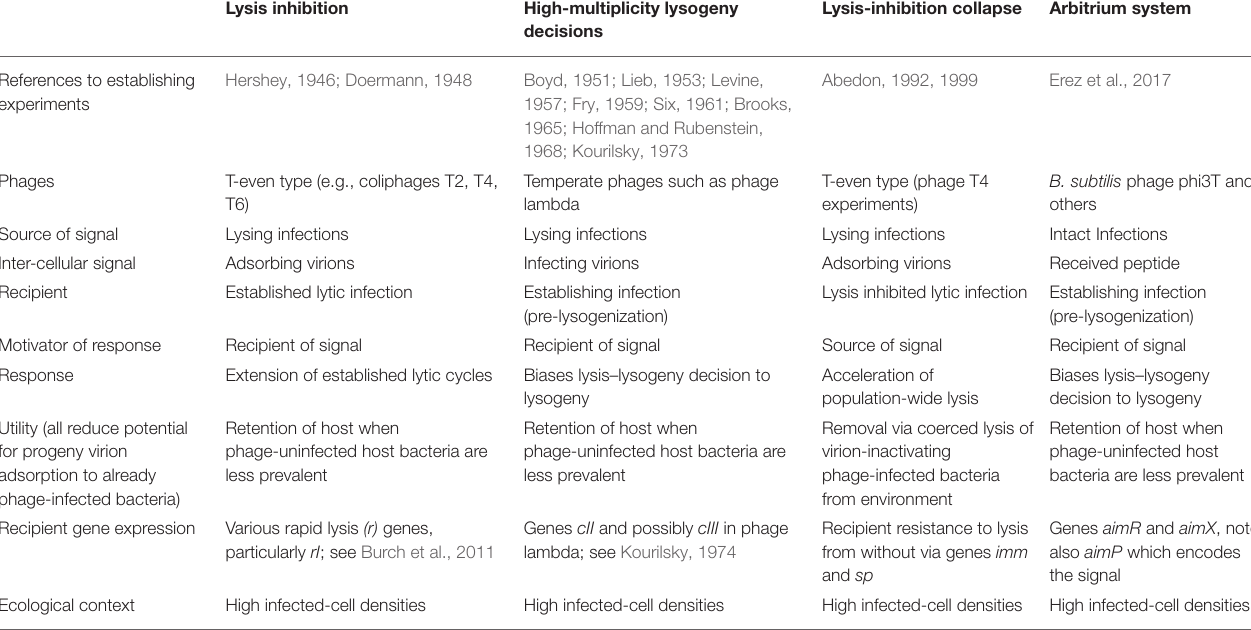
TABLE 1 | Mechanisms of communication between phage-infected